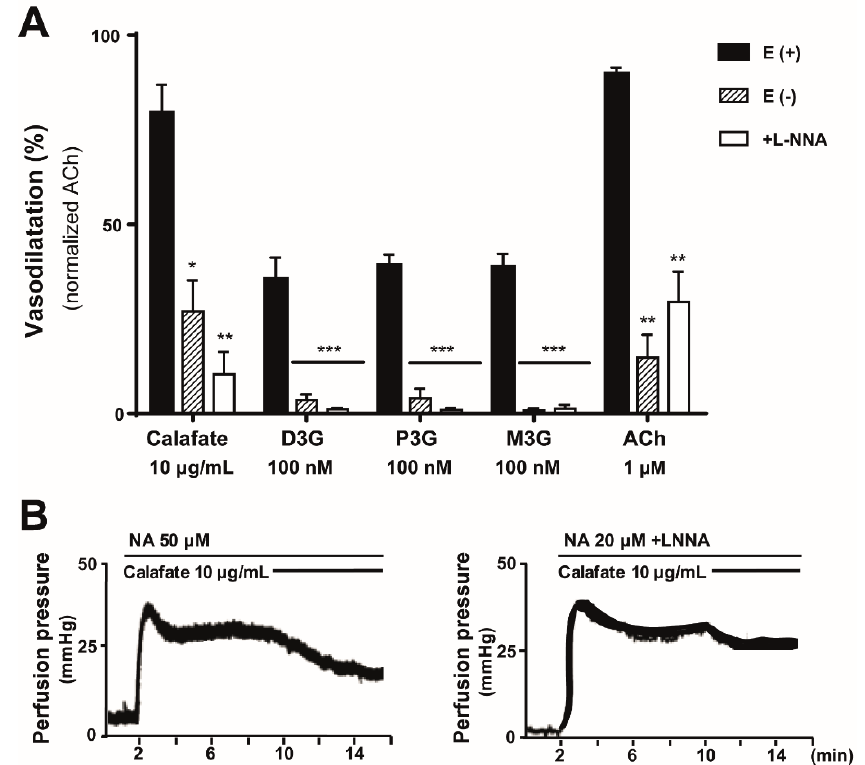
Figure 4. Endothelium-dependent mechanism of the Calafate extract and anthocyanin vasodilation; endothelial nitric oxide synthase enzyme (eNOS) participation. ( A ) The vasodilatation elicited by 10 µg/mL extract (n = 10) or 100 nM of delphinidin-3-glucoside (D3G, n = 6), petunidin-3-glucoside (P3G, n = 6), malvidin-3-glucoside (M3G, n = 4), or acetylcholine (ACh, n = 19) perfused in intact mesenteries or by the same mesentery devoid of endothelium (-). In parallel, separate protocols evaluated the role of eNOS activity after enzyme blockade following tissue perfusion with 150 µM L-NNA. Vasorelaxations were normalized by the 1 µM ACh-induced vasodilation. Columns denote the mean values, bars the SEM. *, p < 0.05, **, p < 0.01, ***, p < 0.001 ( B ) Representative tracings of the vasodilatation elicited by 10 µg/mL Calafate extract before (control) and following eNOS inhibition with L-NNA. Note that after L-NNA treatment, the concentration of NA was reduced to 20 µM, because of tissue sensitization.